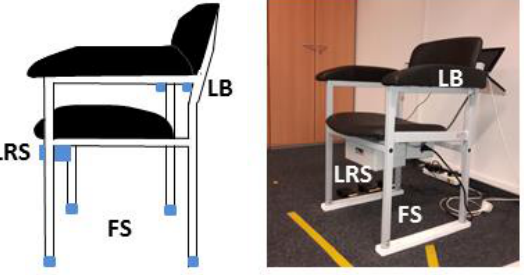
Figure 3. The aTUG system is used for automated TUG tests and includes force sensors (FS) in each chair leg, a laser range scanner (LRS) and a light barrier (LB).